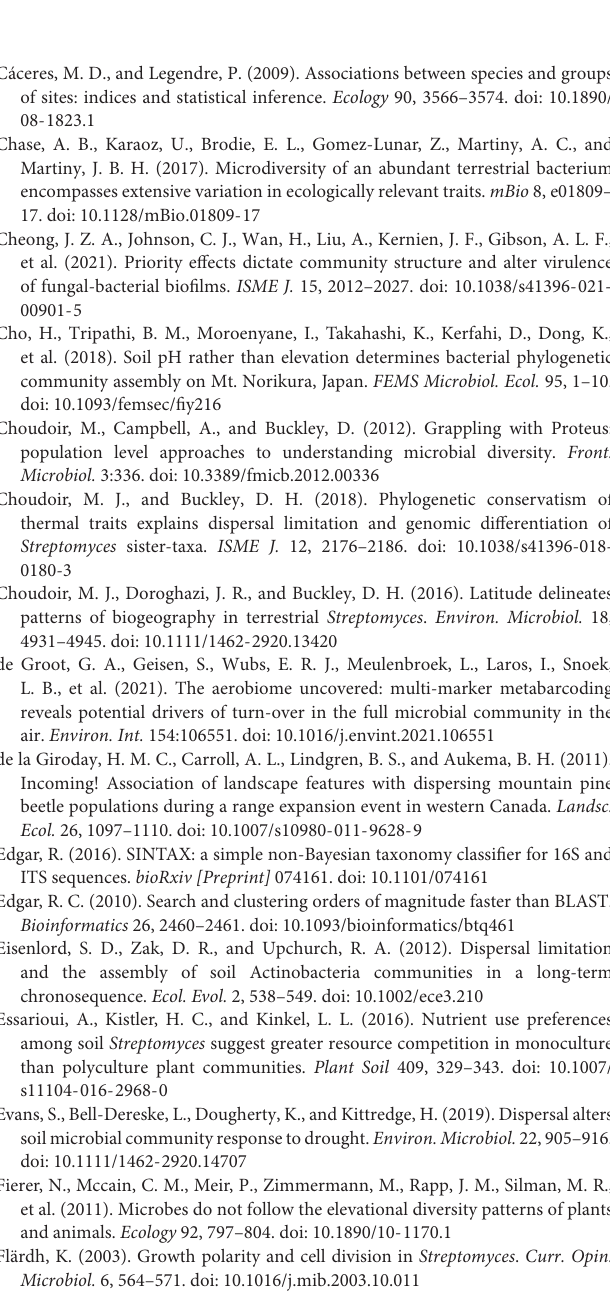
and all WL sites have been sampled to saturation. Supplementary Figure 2 | Elevation and horizontal distance are the best predictors of beta diversity at WM as measured by unweighted UniFrac distance along all measured environmental and spatial